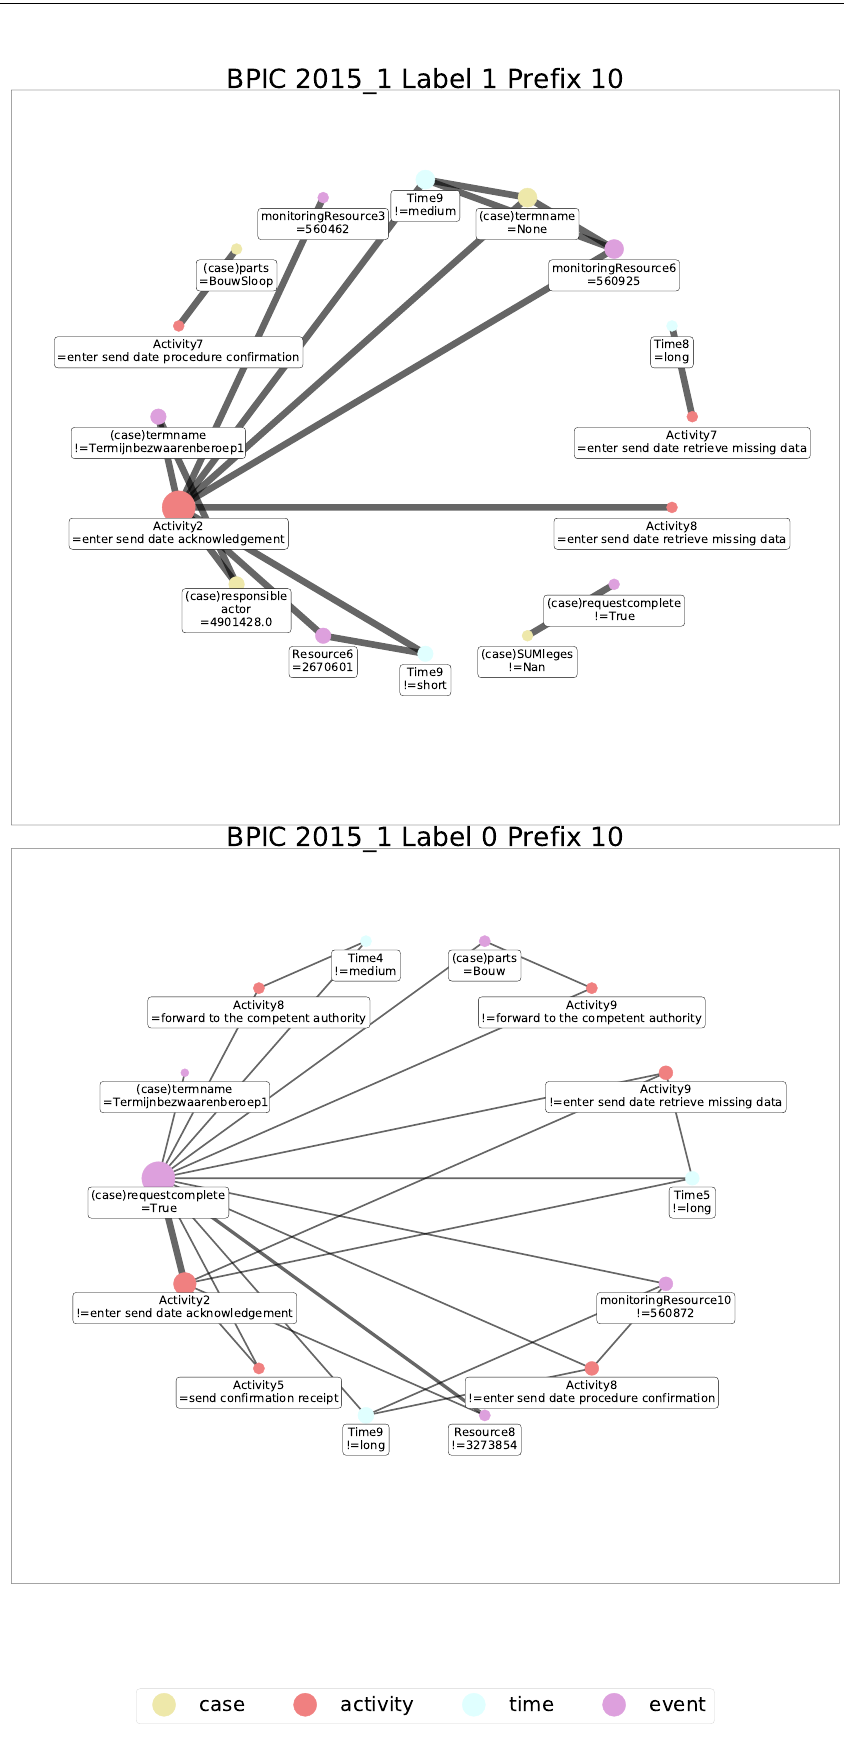
Figure 3. Example of global-level model visualisation (BPIC2015_1 event log at prefix